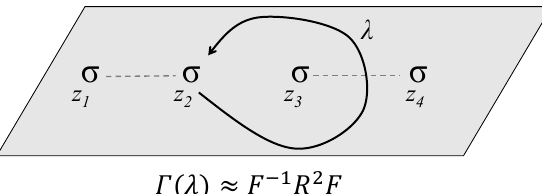
Figure 4: Microscopic braiding as a non-Abelian Berry phase. Consider a system where two pairs of anyons, each denoted by a σ , are created from the vacuum (the pairs are connected by dashed lines) located at positions z ,..., z . Transporting the anyon at position z along any 1 4 2 path λ that encloses only the anyon at z gives rise to non-Abelian Berry phase (6) that acts 3 in the degenerate subspace shown in Figure 3. When the anyons correspond to Ising anyons, to be discussed in detail in Section 3.4, and the transport is adiabatic, this non-Abelian Berry phase will accurately approximate their braid matrix F − 1 R 2 F given by